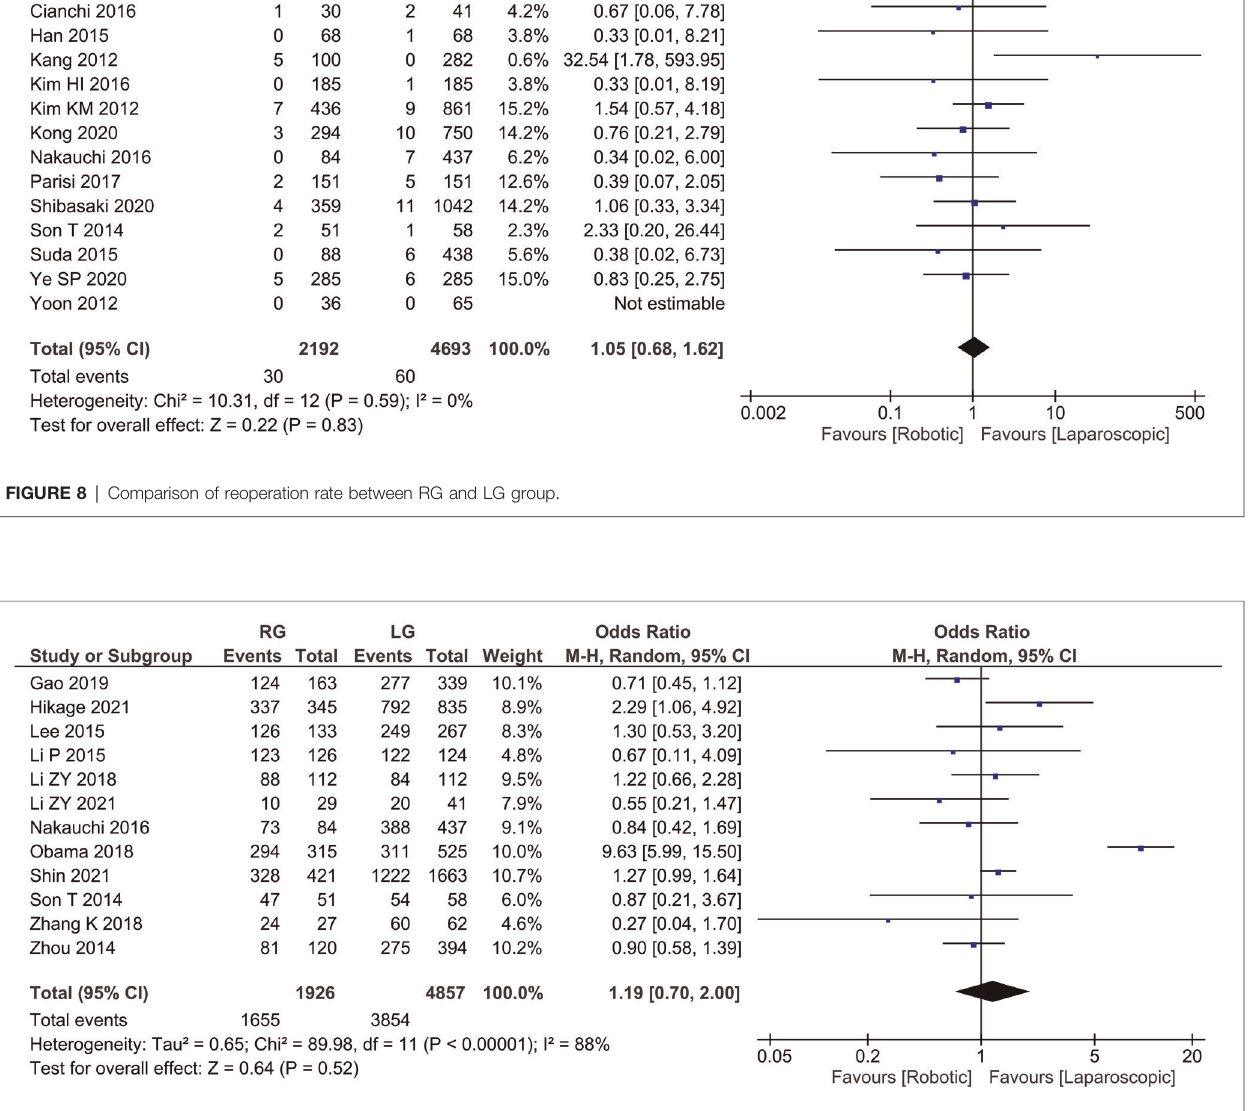
FIGURE 9 | Comparison of 3-year survival rate between RG and LG